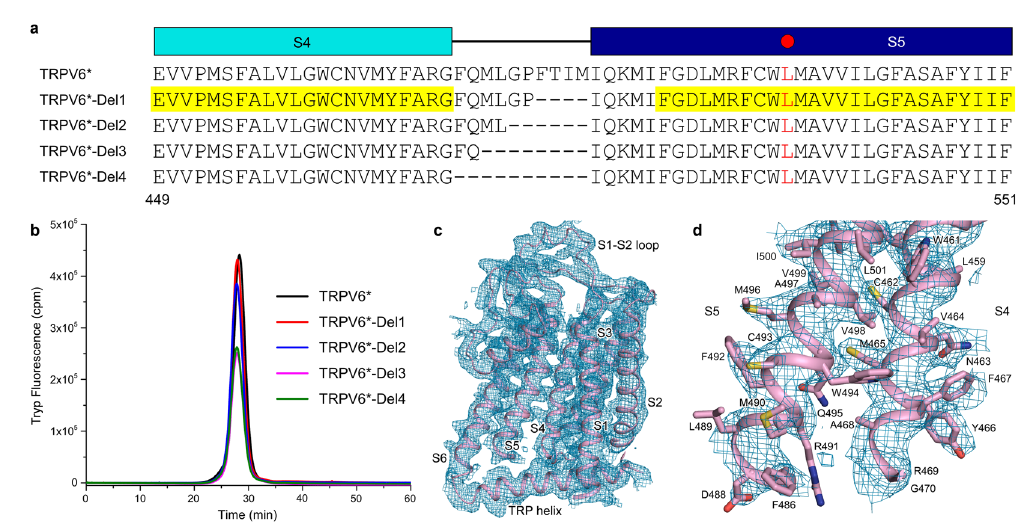
Figure 8. Deletions in S4–S5 preserve TRPV6 tetrameric assembly and generate non-swapped topology. ( a ) Sequence alignment of TRPV6 * and mutants with deletions in the S4–S5 linker. Leucine L495 is indicated by the red circle. The sequence corresponding to the resolved regions in TRPV6 * -Del1 structure is highlighted by yellow. ( b) FSEC traces for purified TRPV6 * without and with deletions in S4–S5 following tryptophan fluorescence. Note, all samples demonstrate a single monodisperse tetrameric peak. ( c) Transmembrane domain of a single TRPV6 * -Del1 subunit demonstrates a non-swapped architecture with the characteristic S6-TRP helix connectivity. Blue mesh shows 2Fo-Fc map (1 σ ). ( d) Close-up view of the S4–S5 illustrating boundaries of a missing region (residues